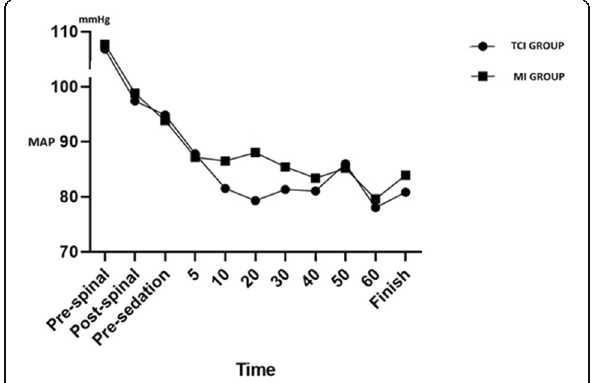
Fig. 4 Changes in peripheral oxygen saturation. Values are mean ± SD